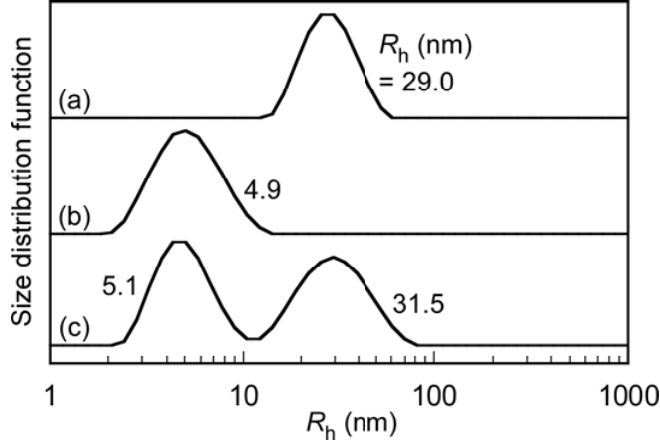
Figure 8. R h distributions of (a) PIC micelles, (b) BSA, and (c) a mixture of PIC micelles with BSA in PBS at 25 °C.